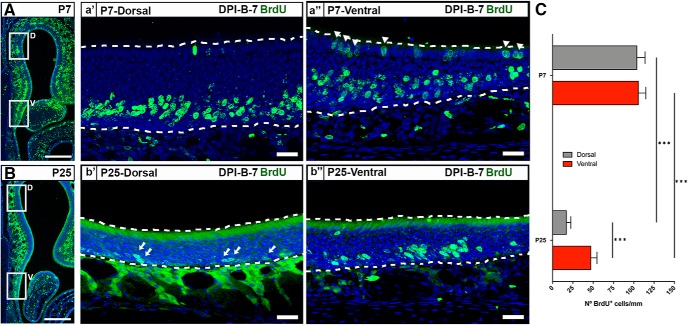
Neurogenesis in the septal OE at P7 and P25. A, P7-born OSNs are evenly distributed in the dorsal and ventral zones of the septal OE. a′, a″, BrdU labeling (green) at DPI-B-7 in the dorsal (a′) and ventral (a″) domains of the septum at P7. B, P25-born OSNs are predominant in the ventral zone of the septal OE. b′, b″, Representative image of BrdU labeling (green) at DPI-B-7 in the dorsal (b′) and ventral (b″) domains of the septum at P25. Note the low density of BrdU+ cells in the dorsal OE at P25 (arrows). C, Histograms show the number of BrdU+ cells in dorsal and ventral zone of the septal OE at P7 (n = 8) and P25 (n = 6). The mean ± SEM values are plotted. ***p < 0.001. Dotted white lines delineate OE luminal surface (top) and basal lamina (bottom). DRAQ-5 is in blue. Scale bars: A, B, 300 μm; a′, a″, b′, b″, 25 μm.